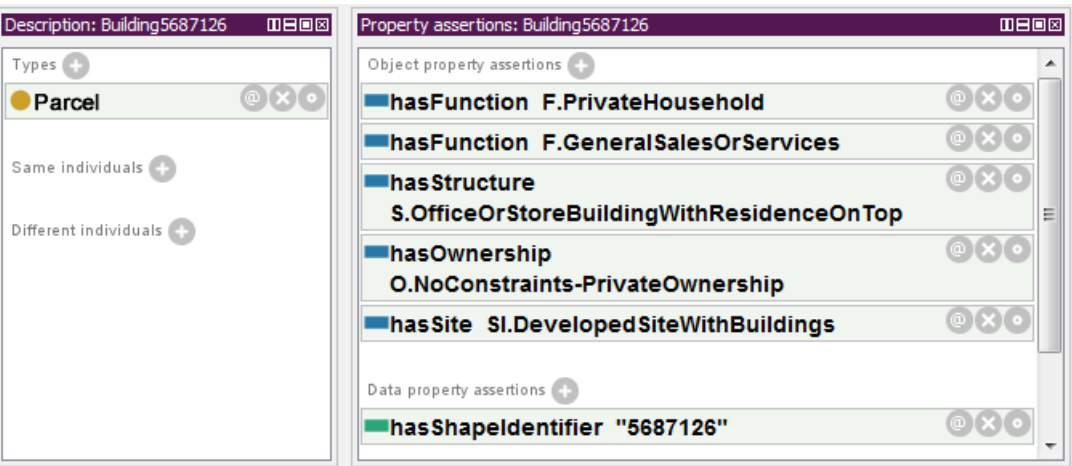
Figure 5. Links between the GIS_Parcel and LBCS ontologies. The link between the GIS_Parcel ontology and LBCS ontology through 5 OWL object properties classifies parcels using the LBCS taxonomy. The datatype property hasShapeIdentifier links the Parcel with the respective ShapeFile by a unique